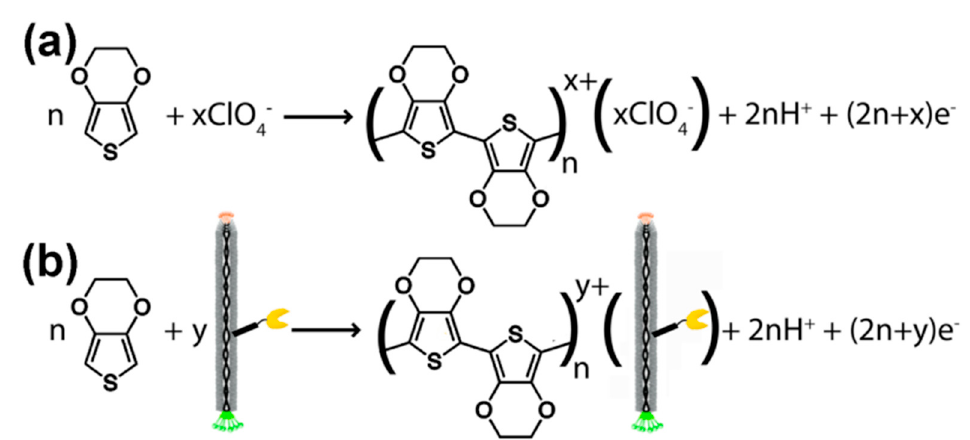
Figure 6. Scheme of the electropolymerization of EDOT (3,4-ethylenedioxythiophene) ( a ) in LiClO 4 and ( b ) in phage solution. Both negatively charged individuals are embedded in the polymer structure. The yellow ‘pacman’ symbolizes PSMA-binding peptide exposed on the pVIII major coat protein of phage. Reprinted with permission from [82]. Copyright 2012 American Chemical Society.